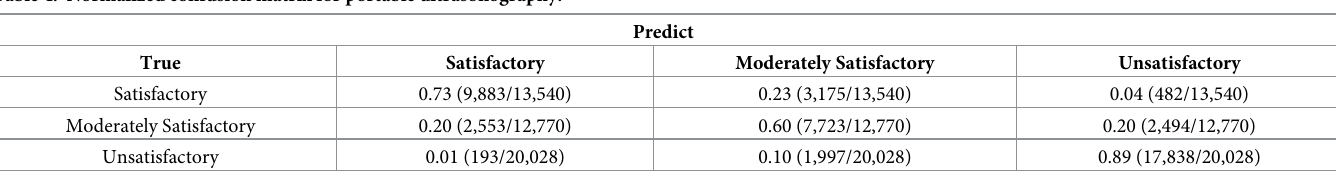
Table 4. Normalized confusion matrix for portable ultrasonography.